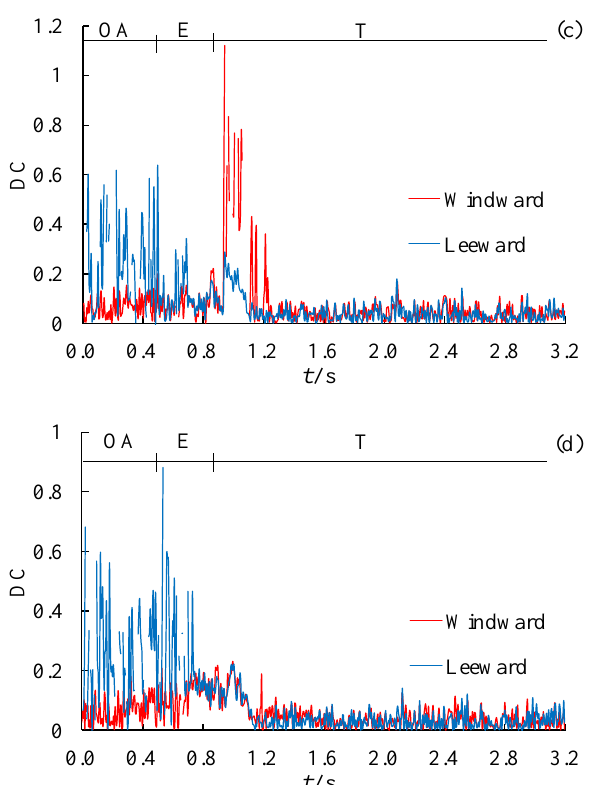
Figure 18. Time-history of head carriage DC conditioned train speed 250 km / h, crosswind velocity 25 m / s, ( a ) 1st wheelset, ( b ) 2nd wheelset, ( c ) 3rd wheelset, ( d ) 4th wheelset (open air (OA); entering entrance (E); tunnel (T)).